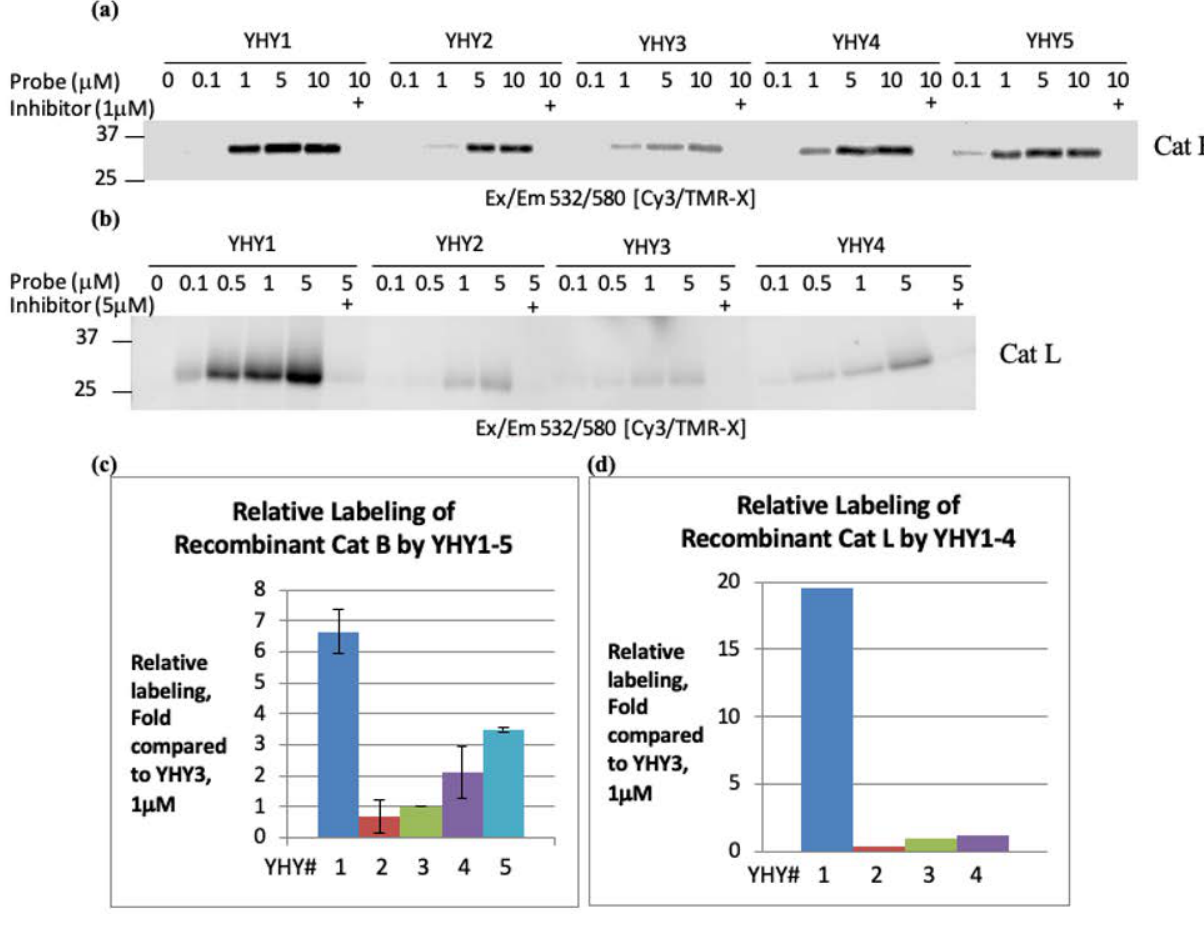
Figure 1. Affinity of YHY probes toward Cat B and L. Labeling of recombinant cathepsin B with YHY probes was conducted twice. Recombinant Cathepsin B was incubated with increasing concentrations of probes YHY1–5. Samples were analyzed by SDS-PAGE, and BODIPY-TMR-X fluorescence was measured by scanning the gel with a Typhoon scanner ( a ). Labeling of recombinant cathepsin L ( b ) was performed similarly to as described in ( a ). Cathepsin B and L bands’ intensity received for each probe was quantified by Image J, relative to YHY3 determined as 1. Probe concentration quantified in ( c , d ) was 1 µ M. YHY# refers to YHY